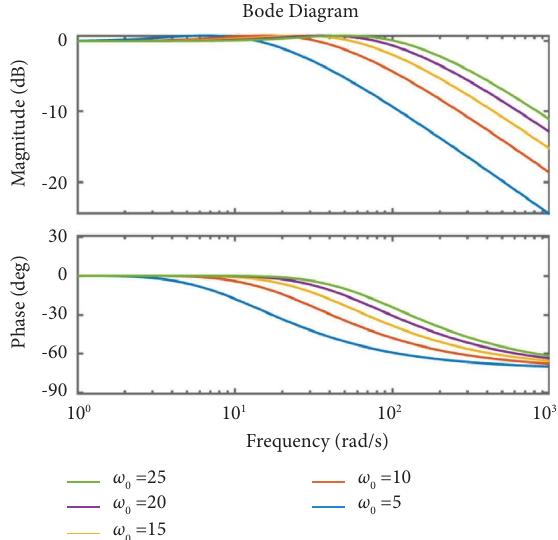
Figure 9: Te frequency-domain characteristic of FOESO obser- vation noise (observer gain ω o